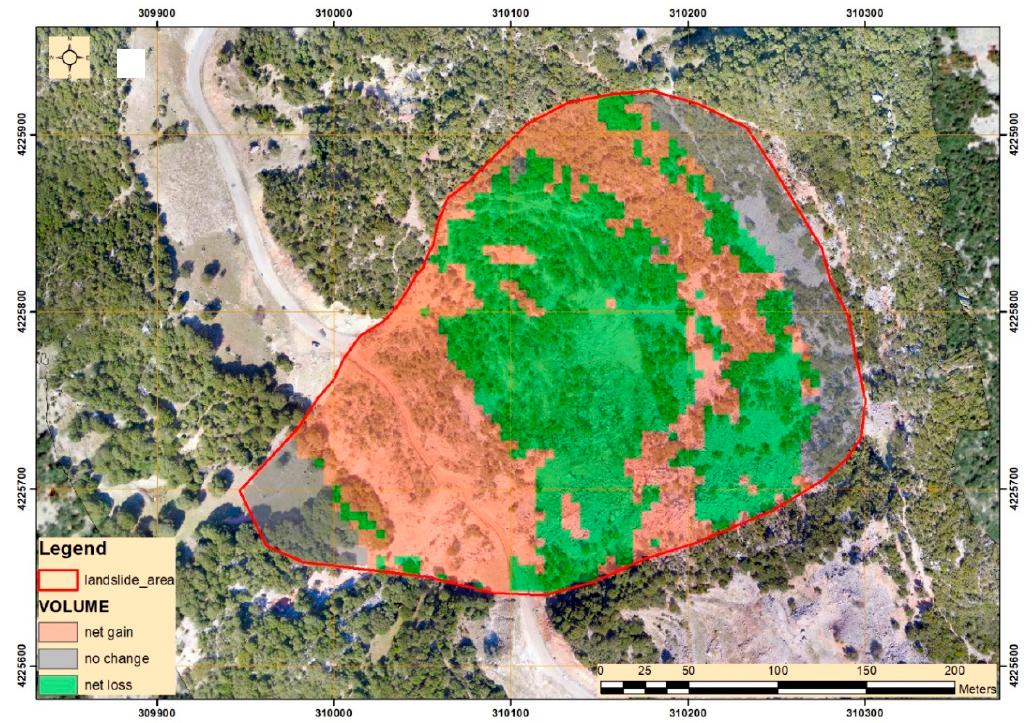
Figure 9. Continuous mapping of the landslide area. ( a ) UAV orthophoto on 28 January 2017. ( b ) UAV orthophoto on 15 February 2017. ( c ) UAV orthophoto on 13 April 2017. ( d ) UAV orthophoto on 23 December 2020. Red arrows show the direction of the movement.